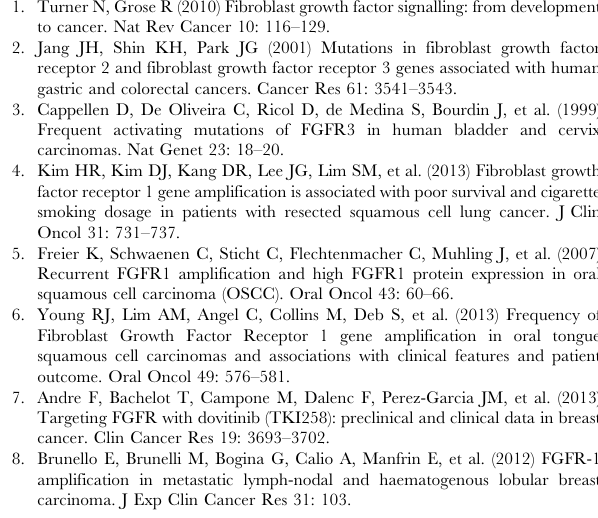
Figure 4. Funnel plots of the association between FGFR amplification and overall survival. (A) Publication bias for FGFR1 amplification and overall survival in various cancers. (B) Publication bias for FGFR2 amplification and overall survival in gastric cancer. Each point represents a separate study. Log [Hazard Ratio], natural logarithm of HR; SE, standard error.